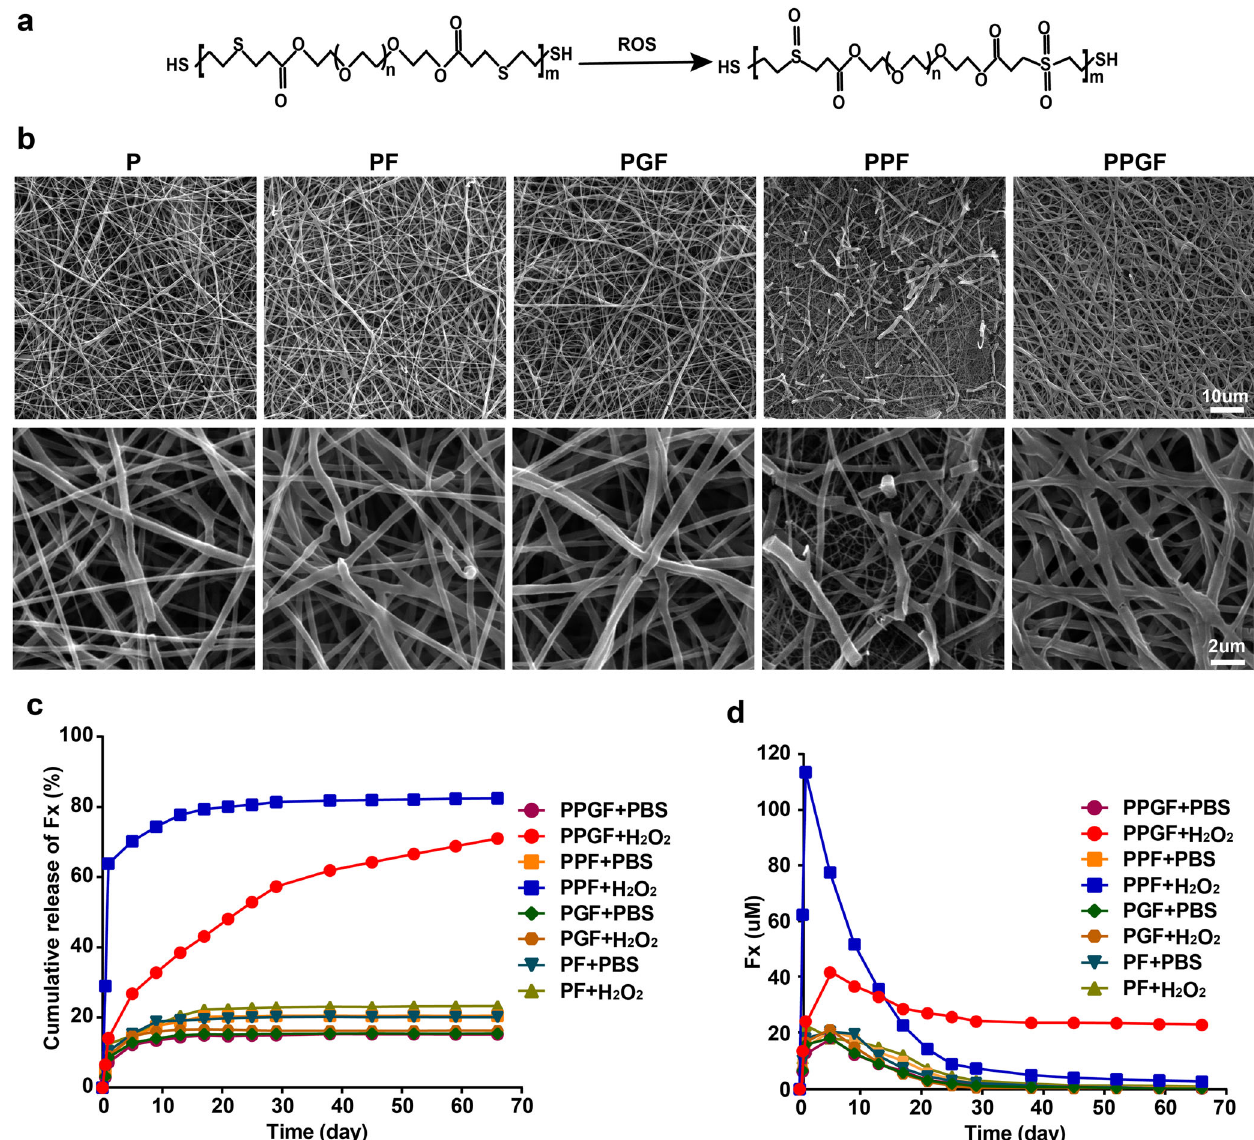
Fig. 4 Drug release and ROS responsiveness of nano fi ber membranes. a The chemical structure of PEGDA-EDT before and after oxidation. b The appearance of fi bers in different nano fi ber membranes after soaking in H 2 O 2 was observed by SEM (Original low magni fi cation: scale bar, 10 μ m; original high magni fi cation: scale bar, 2 μ m). c In vitro cumulative drug release pro fi le of PF, PGF, PPF, and PPGF in PBS with or without H 2 O 2 . d The real-time concentration of drug released from PF, PGF, PPF, or PPGF nano fi ber membranes in PBS with or without H 2 O 2